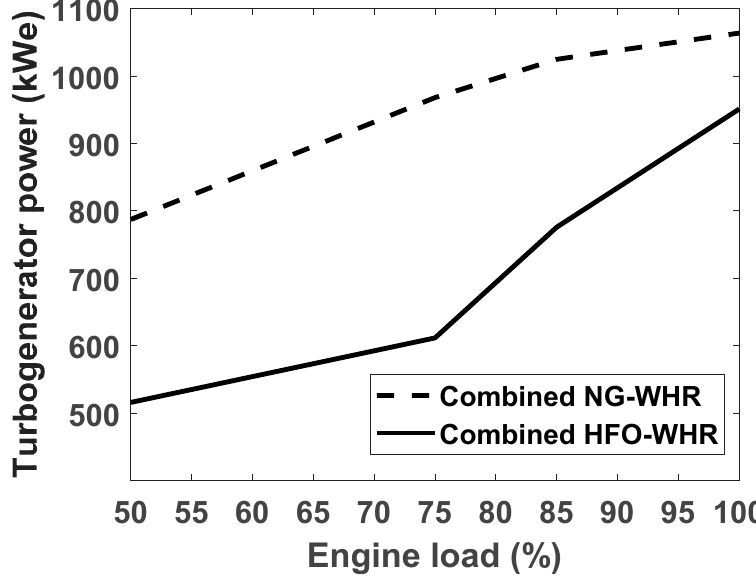
Figure 5. Turbogenerator power dependence on DF engine loads.